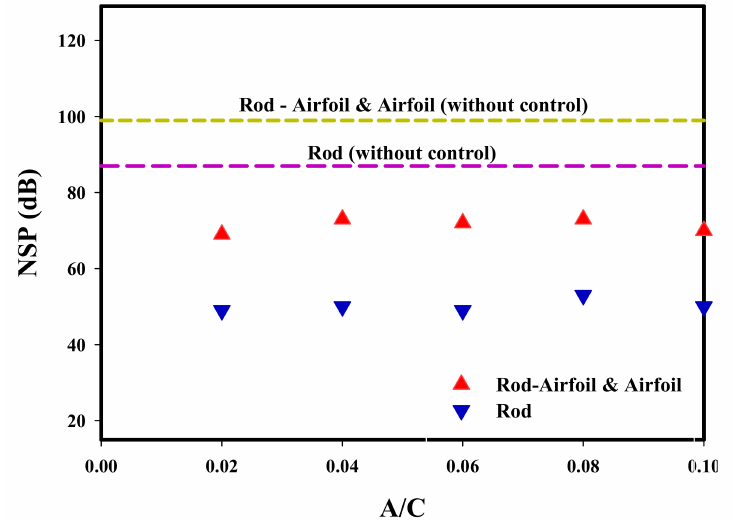
Figure 10. NSP variations recorded by altering the amount of the vibrating displacement